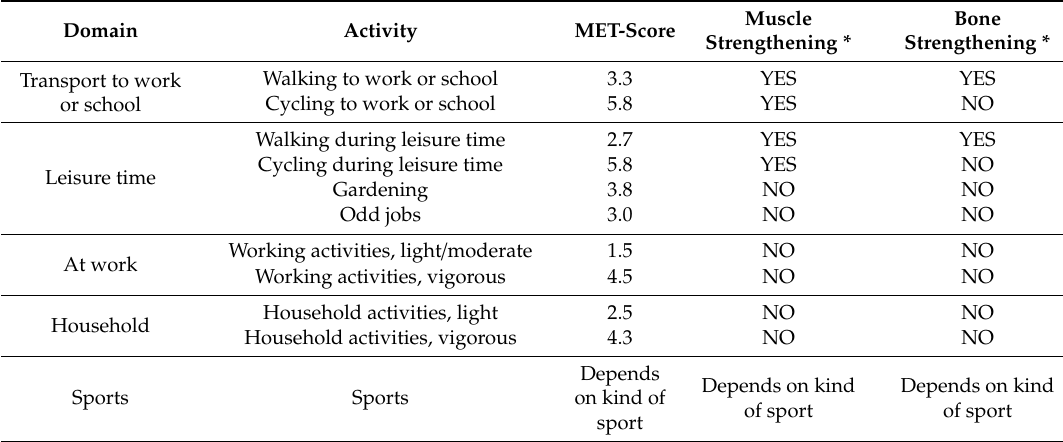
Table A1. Metabolic equivalent (MET) scores of the activities and categorization in muscle and / or bone strengthening activities